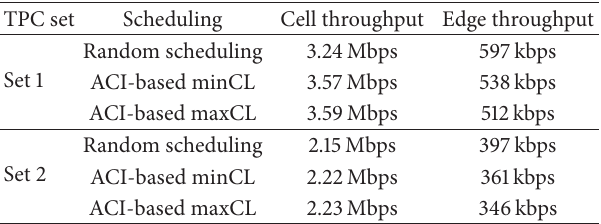
Table 7: Simulation parameters. Table 8: Reference cell throughput and edge